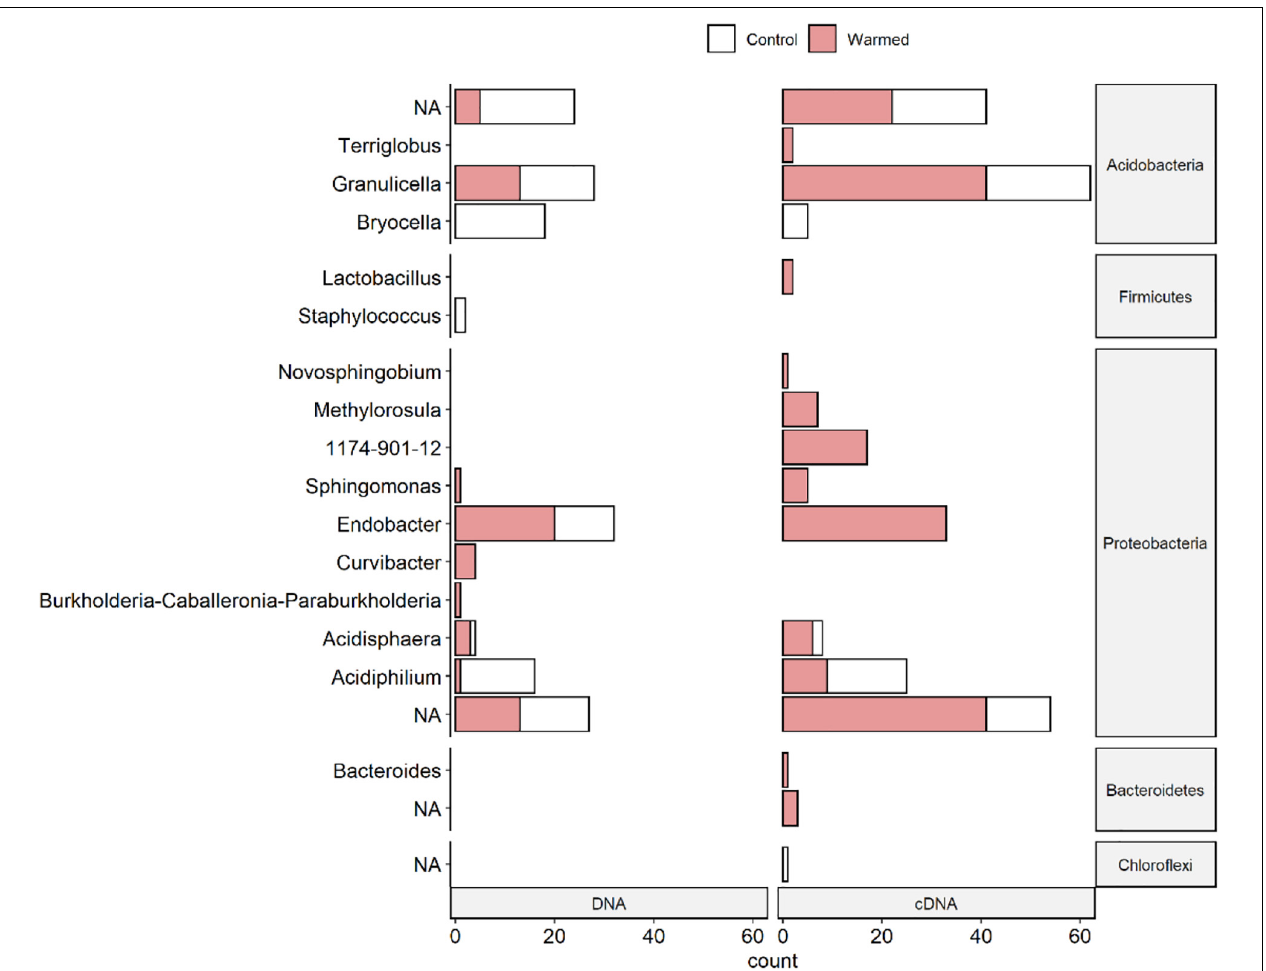
FIGURE 5 | Number of ASVs (amplicon sequence variants) per genus sensitive to warming for DNA and cDNA-based bacterial communities associated with the lichen C. islandica . Sensitivity to warming was determined by differential abundance analysis (DESeq2) and indicator species analysis. ASVs not assigned to genus level are called “NA.” The number of ASVs indicative for the OTC (warmed) treatment is indicated in red and the number of ASVs indicative for the control treatment is indicated in